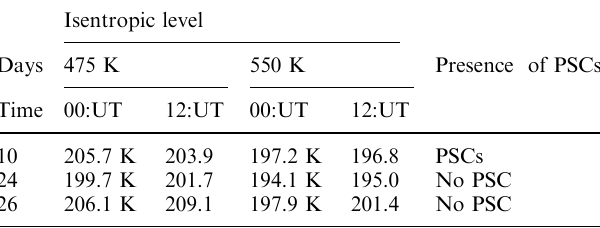
Table 2. Temperature at 475 and 550 isentropics levels Isentropic